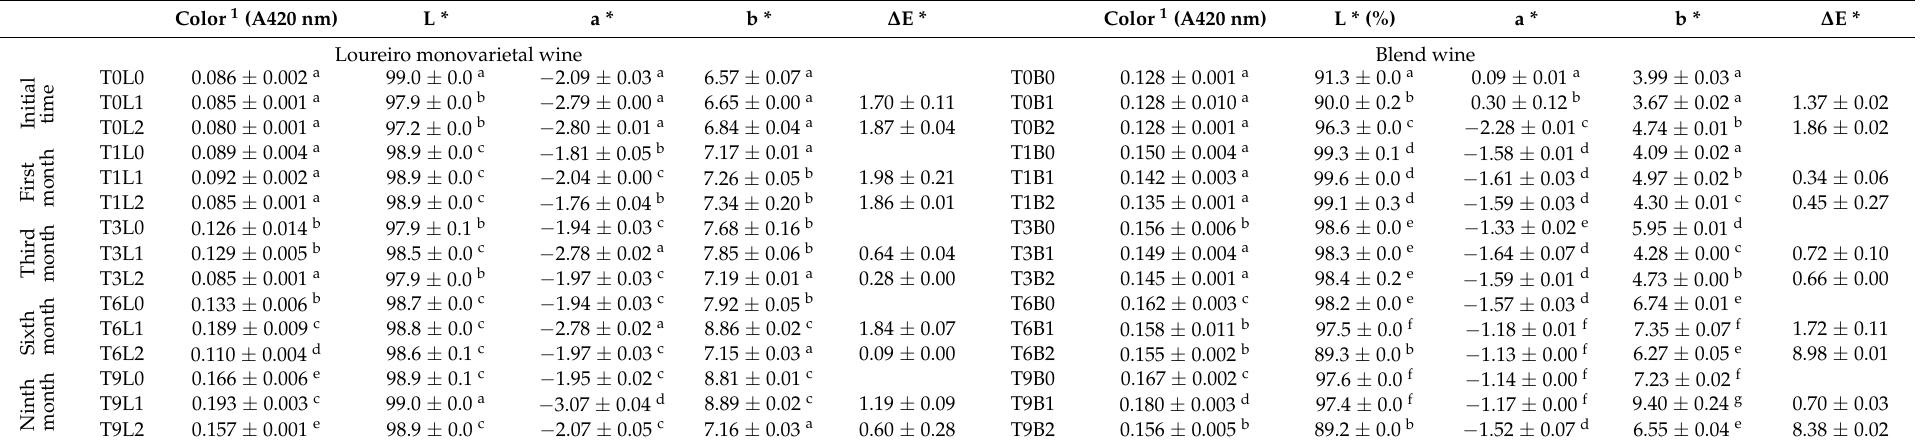
Table 3. Color and chromatic characteristics of the Loureiro monovarietal wine and the Blend wine before and after transportation and deoxygenation over nine months (mean ± standard